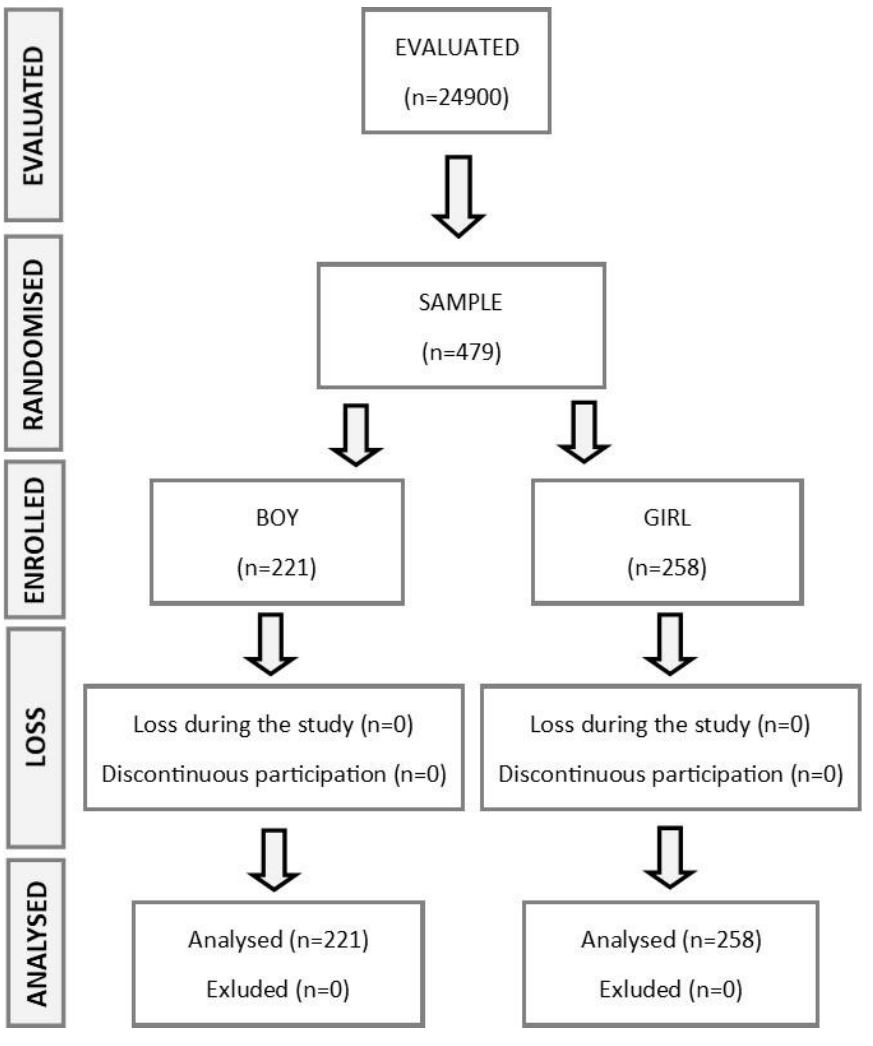
Figure 1. Flow diagram.